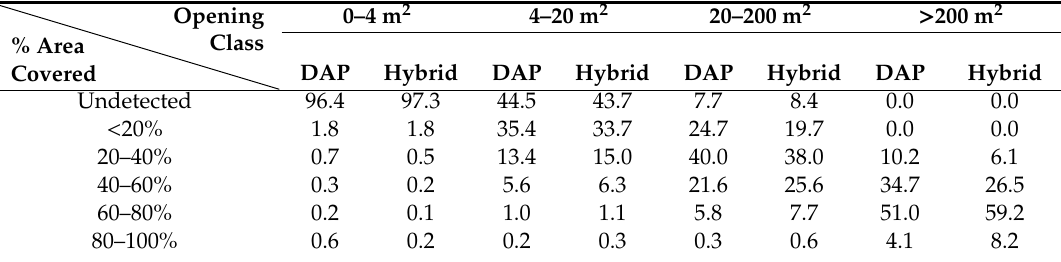
Table 5. Percent area of openings detected by DAP and hybrid datasets with reference to the LiDAR